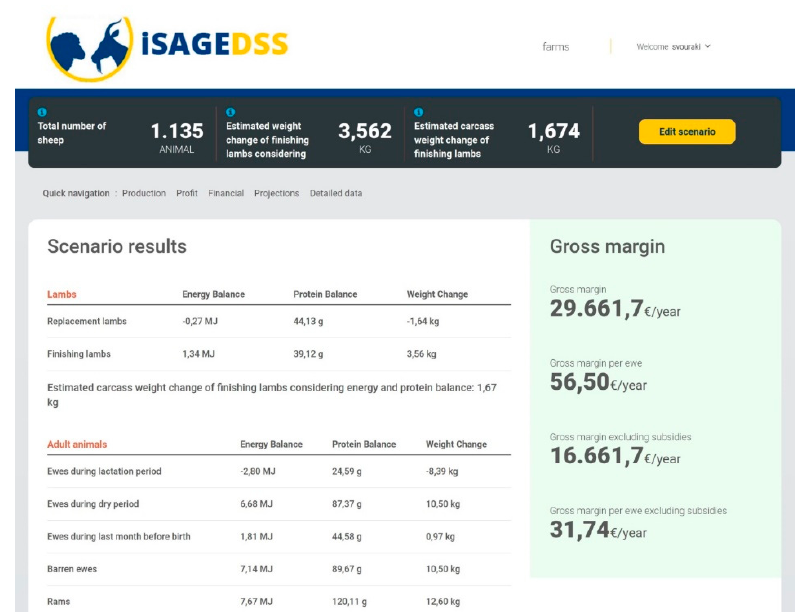
Figure 6. Section of the iSAGEDSS report page with estimated gross margin (with and without subsidies) taking into account production estimates such as live weight and carcass weight change of finishing lambs, based on their energy and protein balance; decimal comma is used as the decimal